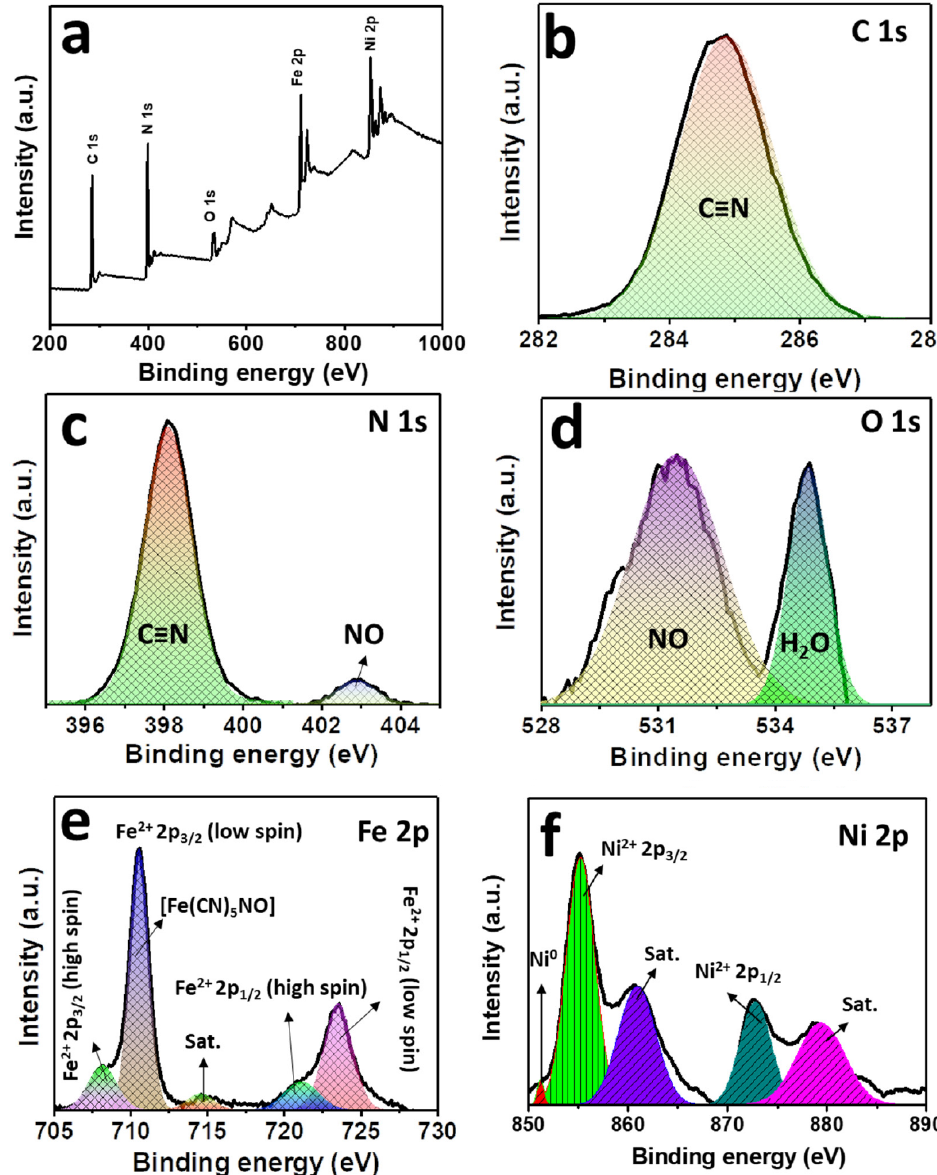
Figure 3. ( a ) XPS survey spectra of NNP. High-resolution XPS spectra of ( b ) C 1s, ( c ) N 1s, ( d ) O 1s, ( e ) Fe 2p, and ( f ) Ni 2p in NNP. The solid lines and the shaded area designate the experimental and fitted data, respectively.